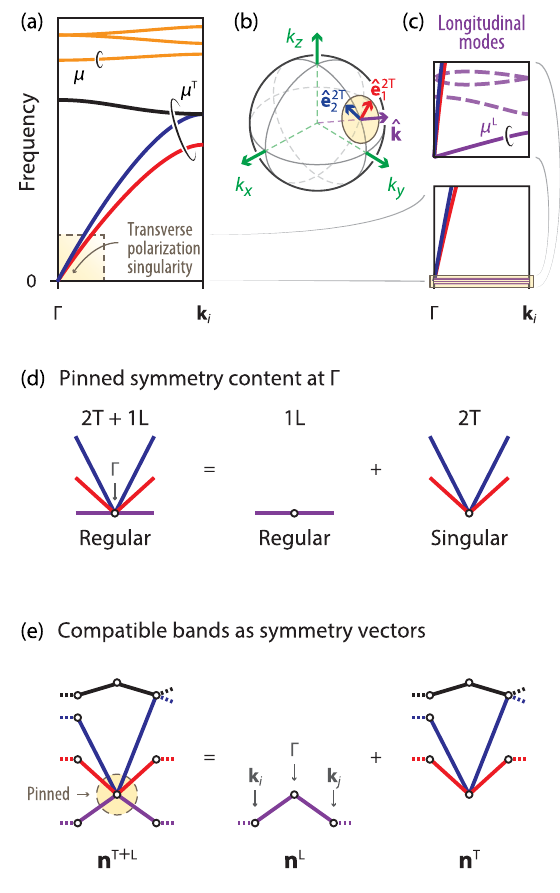
FIG. 1. PhC band connectivity below the fundamental gap. (a) The two lowest-frequency “ lightlike ” PhC bands (blue and red) are pinned to ω ¼ 0 at the Γ point. The minimum connectivity μ T of these bands, i.e., below the fundamental gap, is generally not equal to the minimum connectivity μ of higher bands (orange). (b) The polarization vectors ˆ e 2 T 1 of the ; 2 transverse modes near ω ¼ 0 span a space (yellow disk) that ˆ k varies with wave-vector orientation , rendering their associated symmetry content at Γ singular. (c) In addition to physical, transverse PhC modes, the Maxwell equations also admit a set of nonphysical, longitudinal modes (purple). (d) The singularity can be regularized by adding a longitudinal mode (1L) to the two transverse modes (2T) at ω ¼ 0 . (e) Realizable band configura- tions connected to ω ¼ 0 correspond to compatibility-allowed symmetry vectors n T þ L of the combined transverse and longi- tudinal band set, which is itself a sum of longitudinal and transverse contributions n L and n T